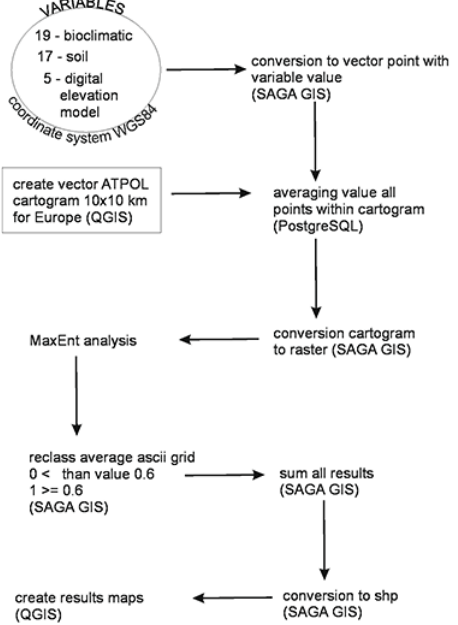
Fig. 1 Data transformation